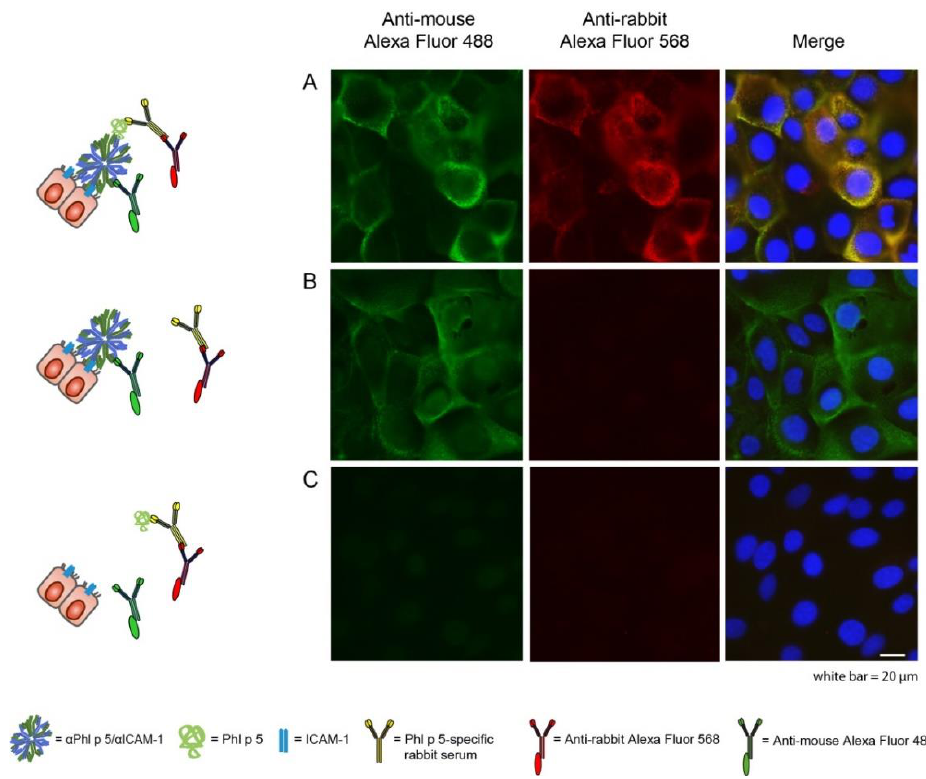
Figure 3. Visualization of αPhl p 5/αICAM -1 conjugates and Phl p 5 on 16HBE14o- cells by im- munofluorescence microscopy. Cells were incubated with αPhl p 5/αICAM -1 ( A , B ) and/or Phl p 5 ( A , C ) and stained with Alexa Fluor 488-labeled anti-mouse antibodies ( left column, green) and Alexa Flour 568-labeled anti-rabbit antibodies ( middle column, red) to visualize αPhl p 5/αICAM -1 and Phl p 5, respectively. Nuclei were stained with 4',6-diamidino-2-phenylindole dihydrochloride (DAPI) (blue), and merged images are shown in the right column. Scale bar is 20 µm. Experiments were performed in duplicates. Data shown are representatives of two independent experiments.